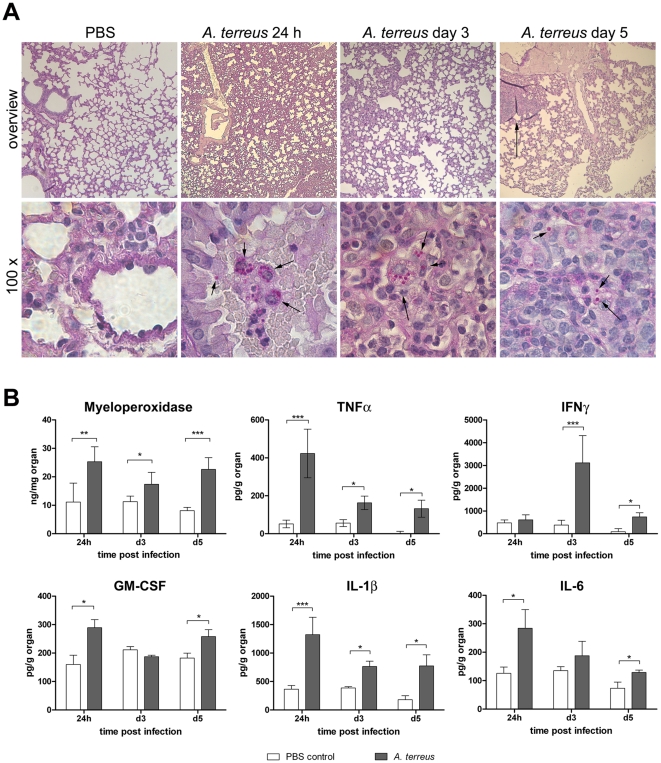
Persistence of A. terreus conidia in the lungs of immunocompetent mice.Infection was performed with A. terreus SBUG844. (A) Histological sections, Periodic-Acid-Schiff stain. 24 h, day 3, day 5: time after infection. Upper row: overview 4× magnified; the arrow indicates immune cell infiltrate. Lower row: 100× magnified; arrows indicate A. terreus conidia stained in pink. Scale bars represent 100 µm (overview) and 10 µm (100×). (B) Immune response in the lungs determined by myeloperoxidase and cytokine levels. White bars: PBS-mock infected mice; grey bars: A. terreus infected mice. Data shown as mean+SD from 5 animals per group. Statistical analysis was performed per time point by unpaired, two-tailed t-test. * P<0.05; ** P<0.01; *** P<0.001.